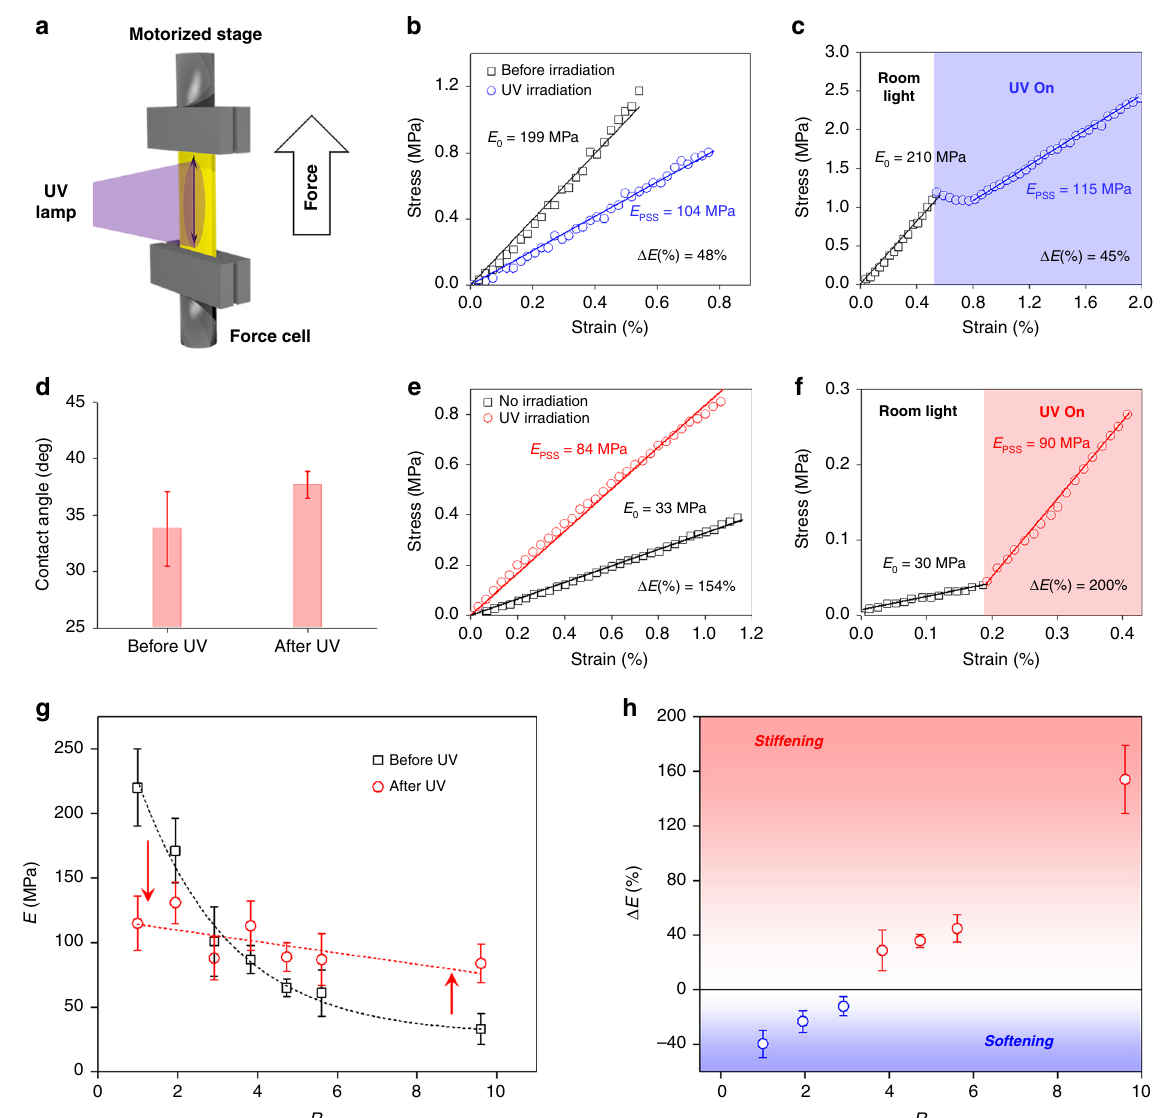
Fig. 3 Active modulation of stiffness in response to light. a Photo-tensile experiments on fl at ribbons. The polymer is stretched parallel to the molecular alignment, as indicated by a black double-headed arrow. The stiffness of the material adapts to illumination. b Ex situ stress – strain curves for a R = 1 material, in room-light condition (black squares) and under irradiation (blue circles). We de fi ne R as the molar ratio between the free liquid crystal and the molecular photo-switch. c In situ stress – strain curve for material with R = 1. The fi lm is initially strained in ambiant conditions (black squares) and then exposed to UV light (blue circles). When the light is switched on, the material requires time to adjust to the new illumination conditions, which is visible in in situ tensile measurements. d Contact angle of free liquid crystal on a fully polymerized, unswollen polymer network, before and after activation with UV light. The contact angle increases upon light activation. e Ex situ stress – strain curves for material with R = 9.6 in room-light condition (black squares) and under irradiation (red circles). f In situ stress – strain curves: the material is fi rst strained (black squares) and then exposed to UV light (red circles). g Average Young modulus before (black squares) and after irradiation (red circles), for increasing proportions of free liquid crystal in the material. Error bars correspond to standard deviation. h Photo-induced variation of the Young modulus, for increasing proportions of free liquid crystal in the material. Error bars correspond to standard